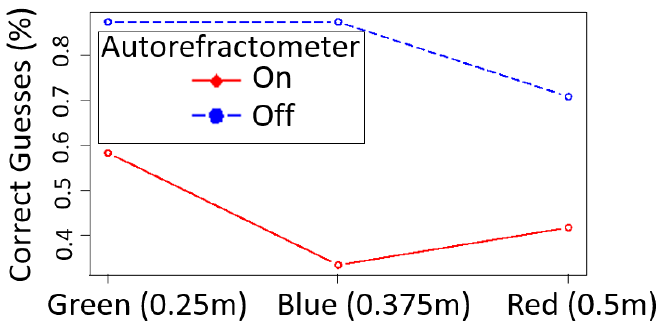
Figure 6. Overall percentage of correct guesses for each pillar when the autorefractometer was on (red line) and off (blue